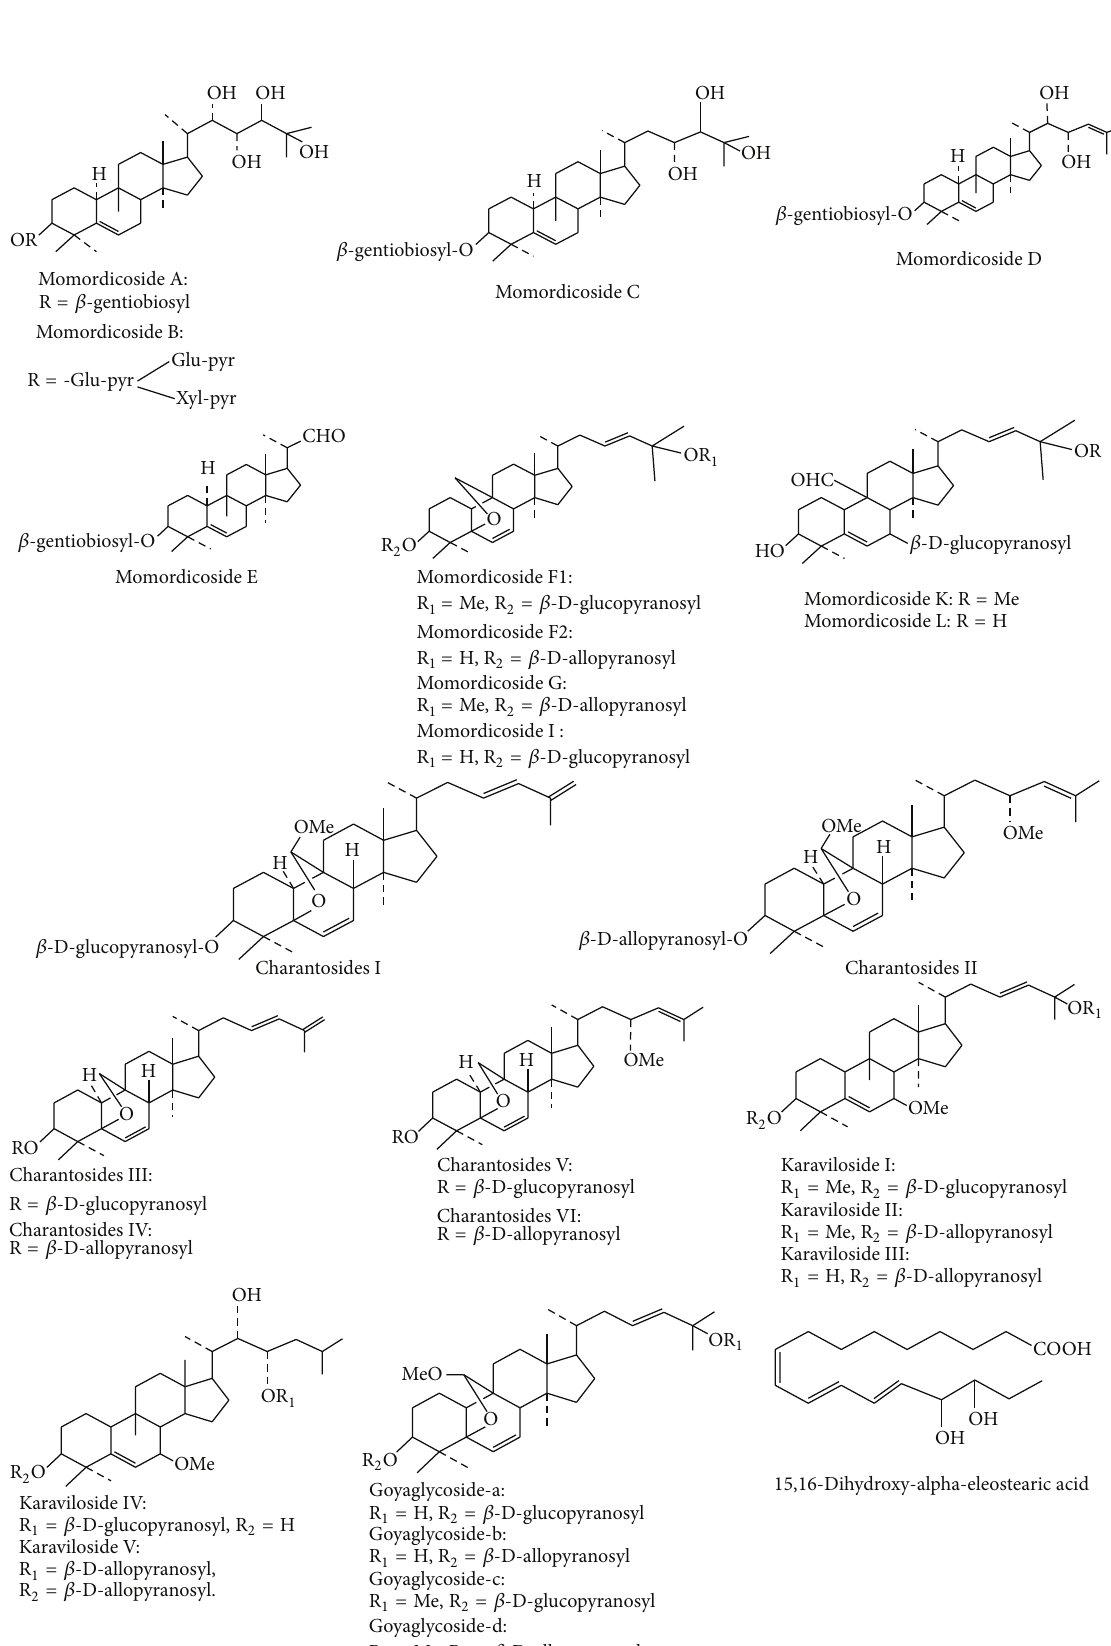
Figure 4: Chemical structure of major cucurbitane glycosides isolated from M. charantia